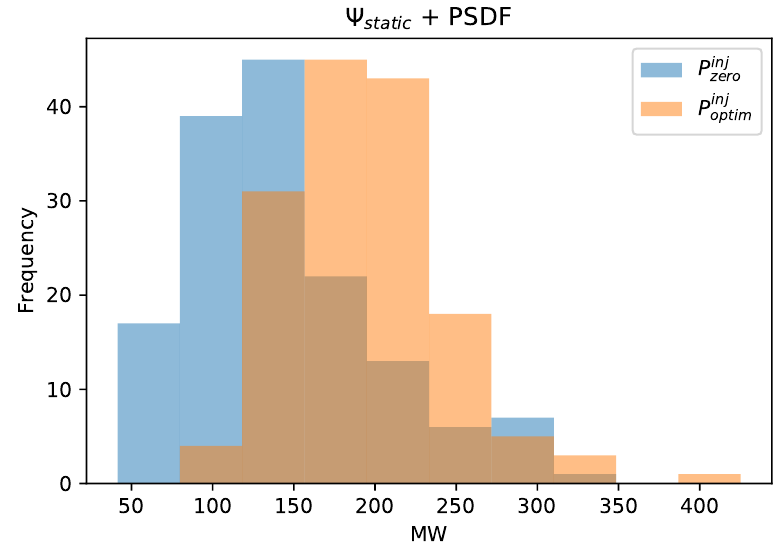
Figure 4. Error distribution for the explicit PST representation when applying the P inj zero and P inj